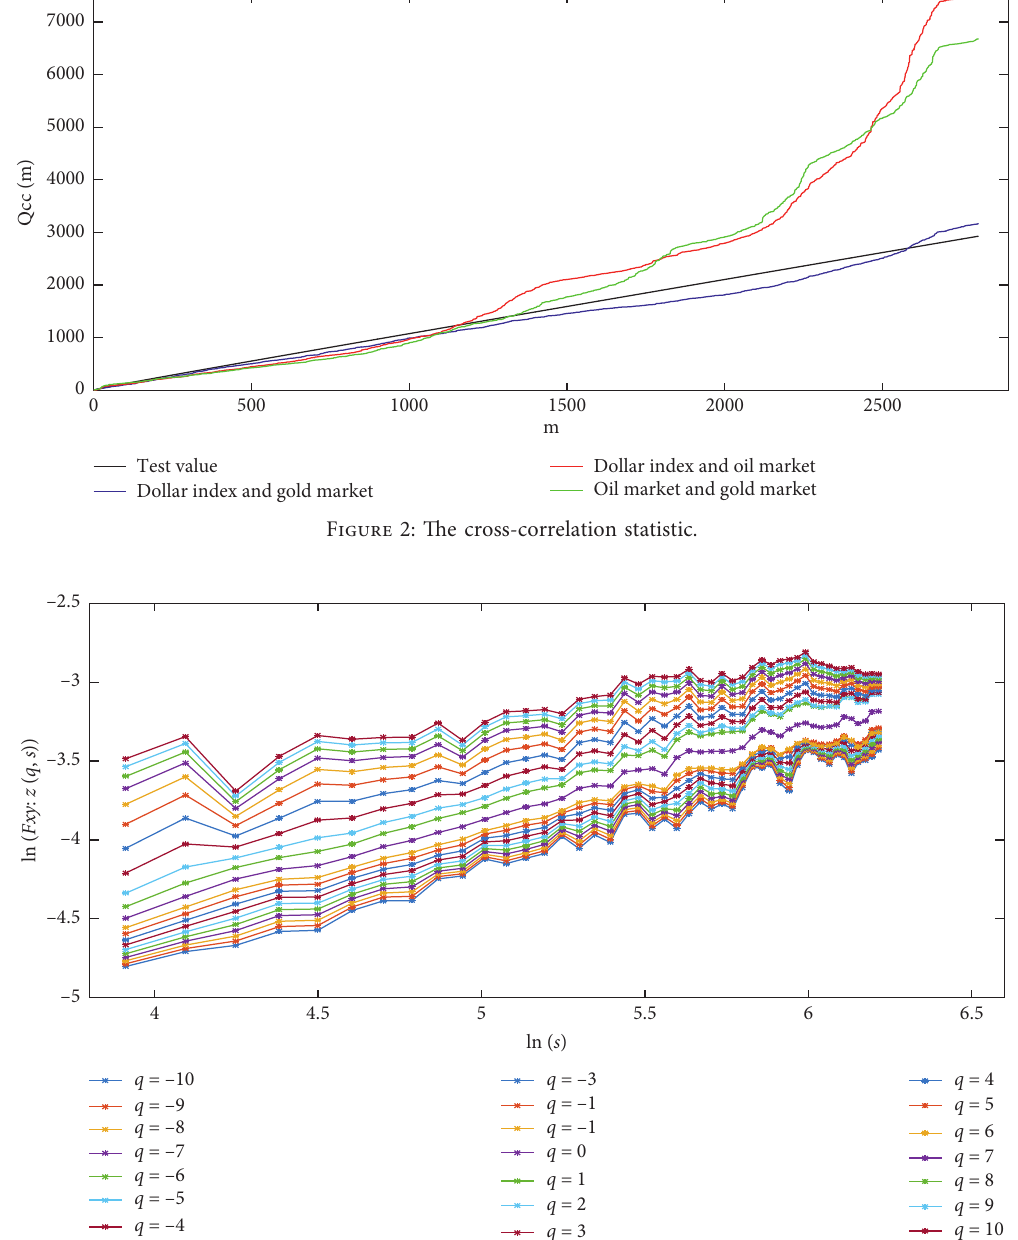
Figure 3: Log-log plots of F